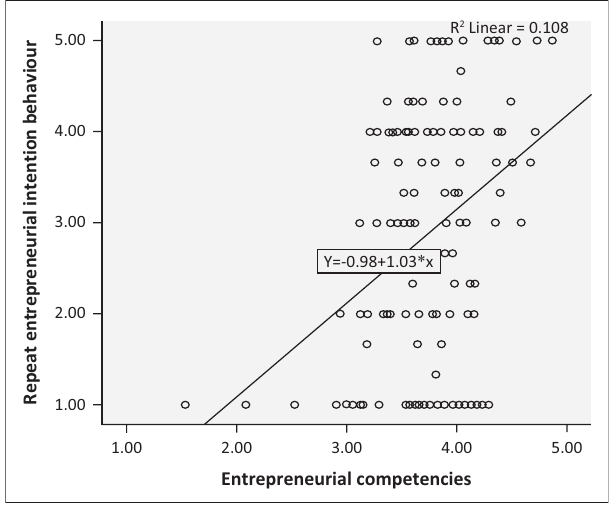
FIG URE 6: Scatter plot showing the relationship between recurring entrepreneurial intention behaviours and entrepreneurial competencies.